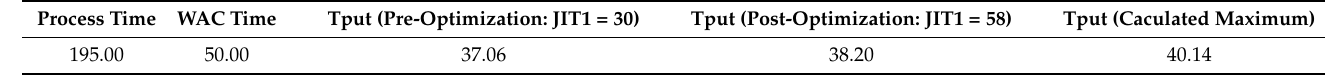
Figure 10. Throughput comparison of JIT1, before ( left ) = 37.06 and after ( right ) = 38.20. Table 3. Throughput comparison of